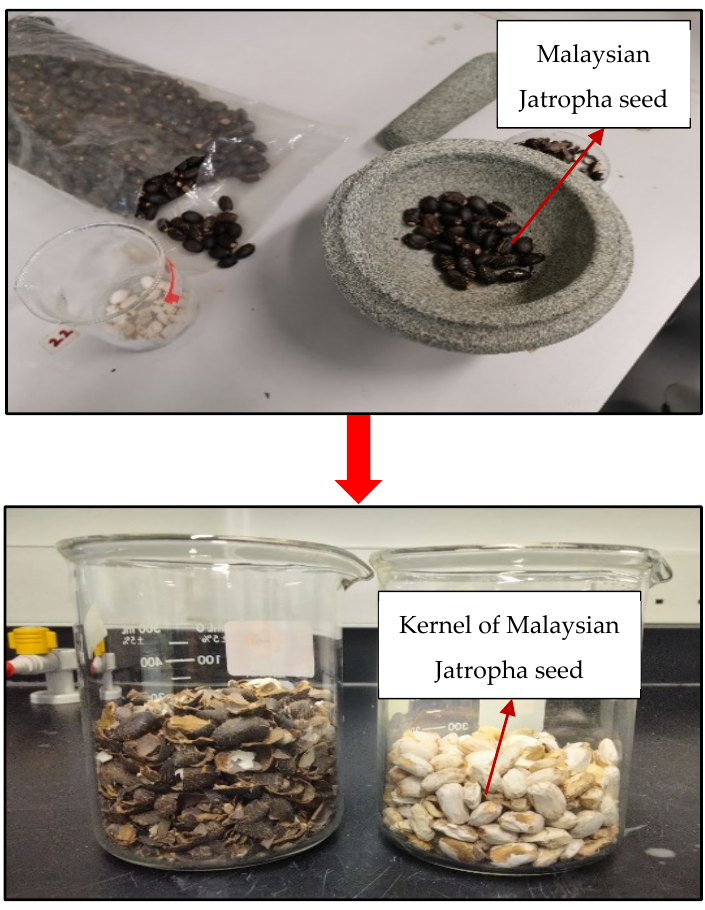
Figure 1. Kernel of Malaysian Jatropha seed.